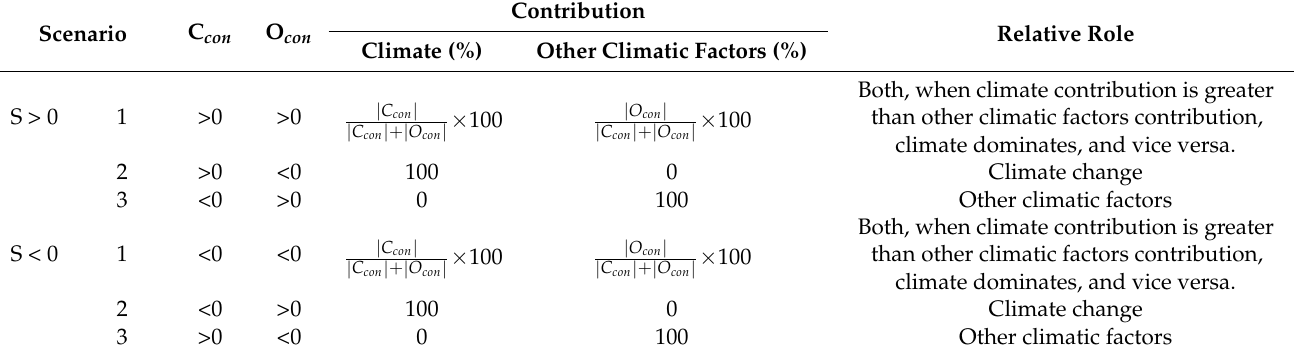
Table 2. Six scenarios for quantifying the contribution proportions of climate and humans to F old of restoration and